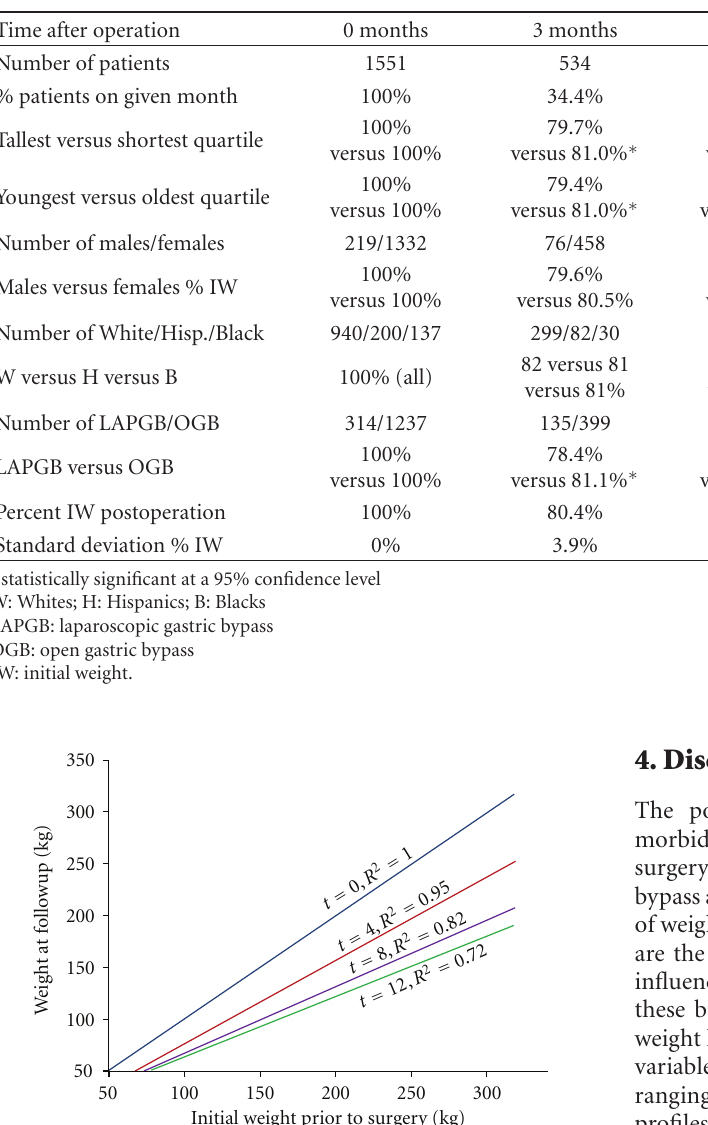
Table 1: Method 1 results.